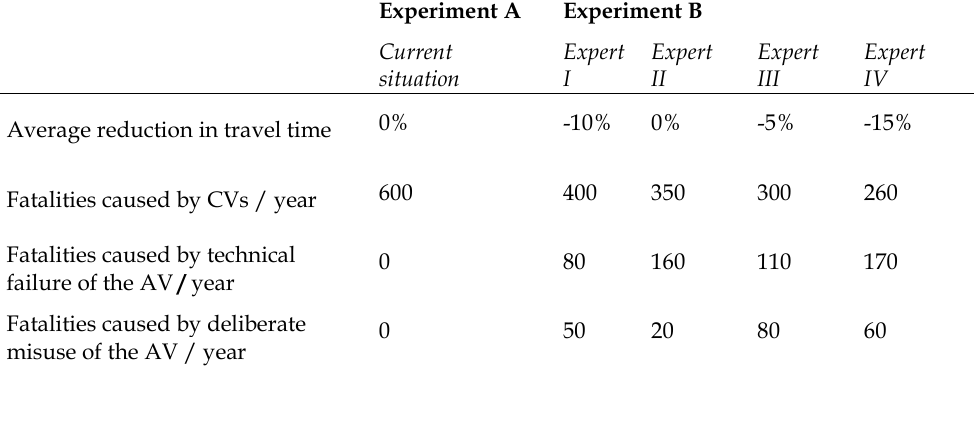
Overview of the reference levels in experiments A and B Experiment A Experiment